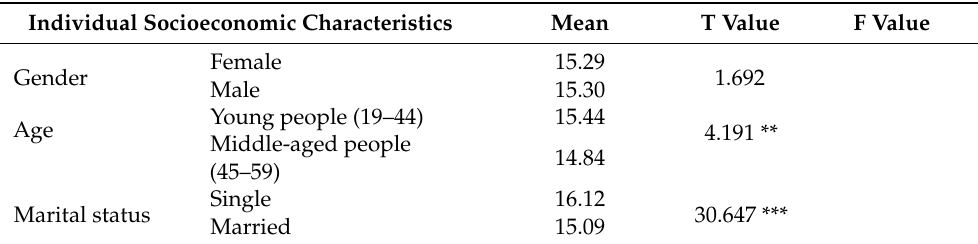
Table 3. Results of independent samples t -test/one-way ANOVA of mental health based on individual socioeconomic